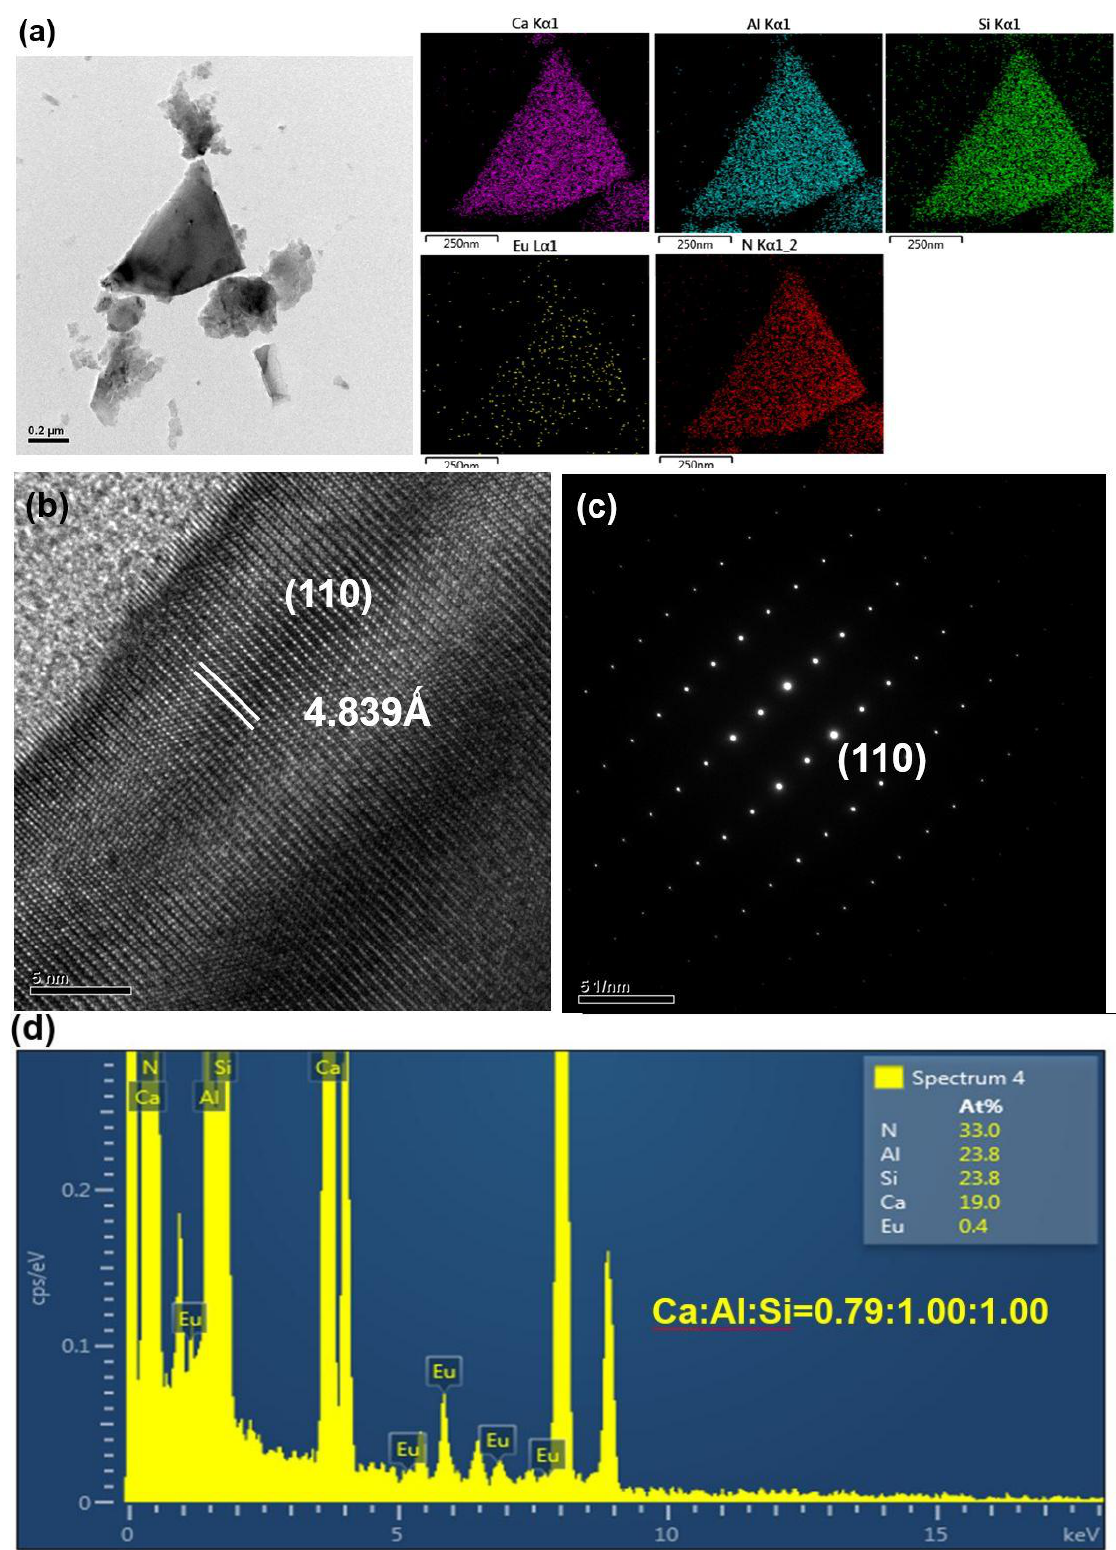
Figure 8. ( a ) TEM image and corresponding element mapping of Ca, Al, Si, N, and Eu; ( b ) HRTEM image; ( c ) SAED pattern; and ( d ) element analysis of a plate-like particle (showing it to be CaAlSiN 3 :Eu 2+ ) in a product synthesized with Ca:Al:Si:Si 3 N 4 :Eu 2 O 3 :NaN 3 :NH 4 Cl = 1.5:1.0:0.25:0.25:0.02:3.5:0.6.